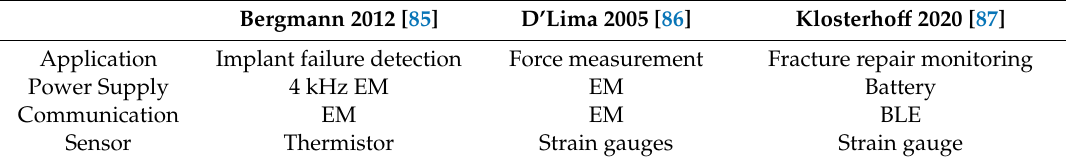
Table 5. Comparison of select smart orthopedic implants. EM—electromagnetic.